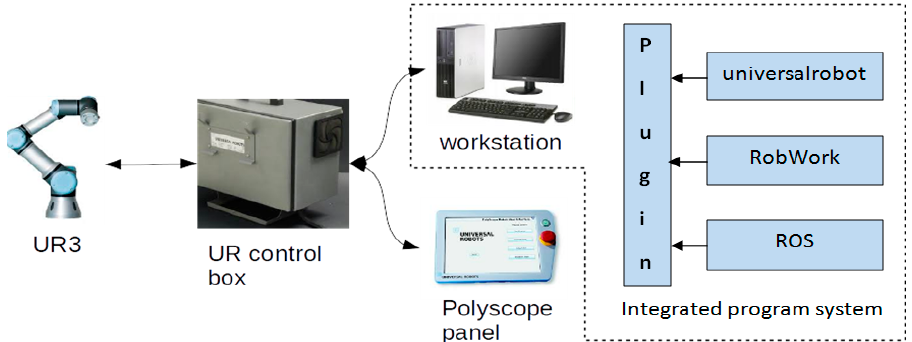
Figure 7. Subsystems interactions of laboratory setup.